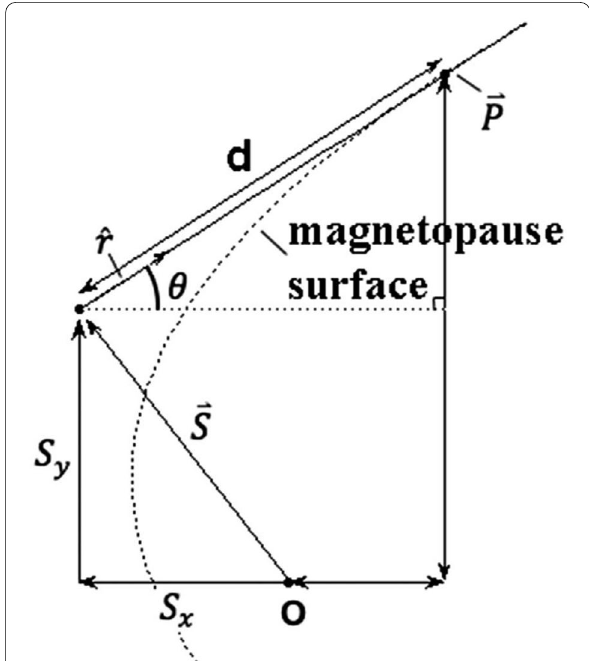
Fig. 3 Reconstruction geometry variables for the derivation of the general formula for the reconstruction of magnetopause from the spacecraft position, (cid:31) s , parameterized by tangent angle, θ (Figure adapted from Collier and Connor